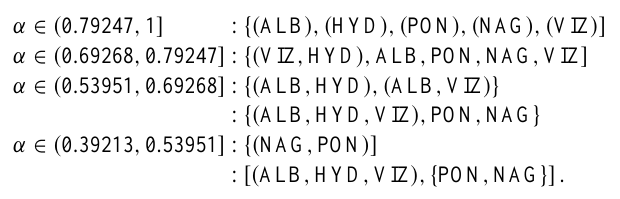
Fig. 6. Dendogram for vertical Z